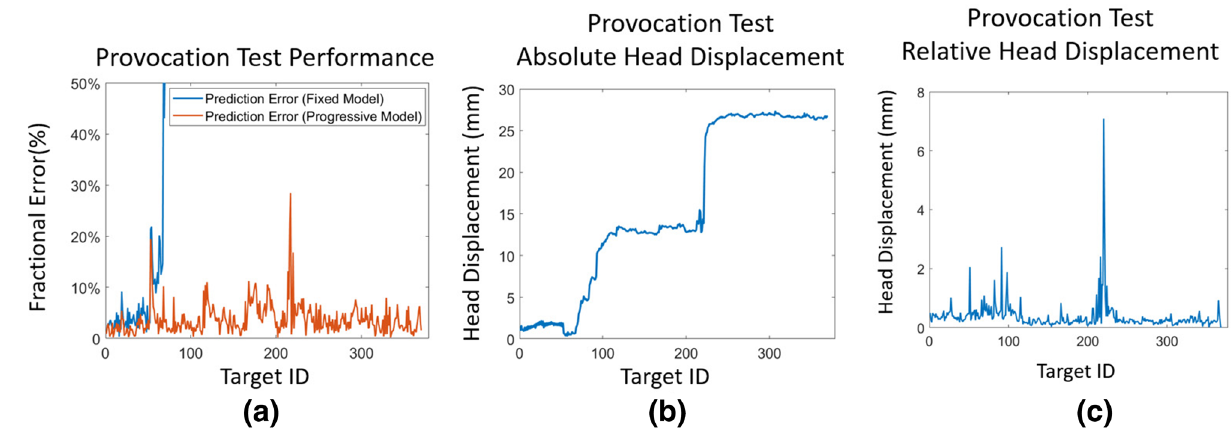
Figure 10. Provocation test results: ( a ) prediction errors for the fixed model (blue) and progressive model (orange). ( b ) Absolute head displacement from the pose at the first fixation event. ( c ) Relative head